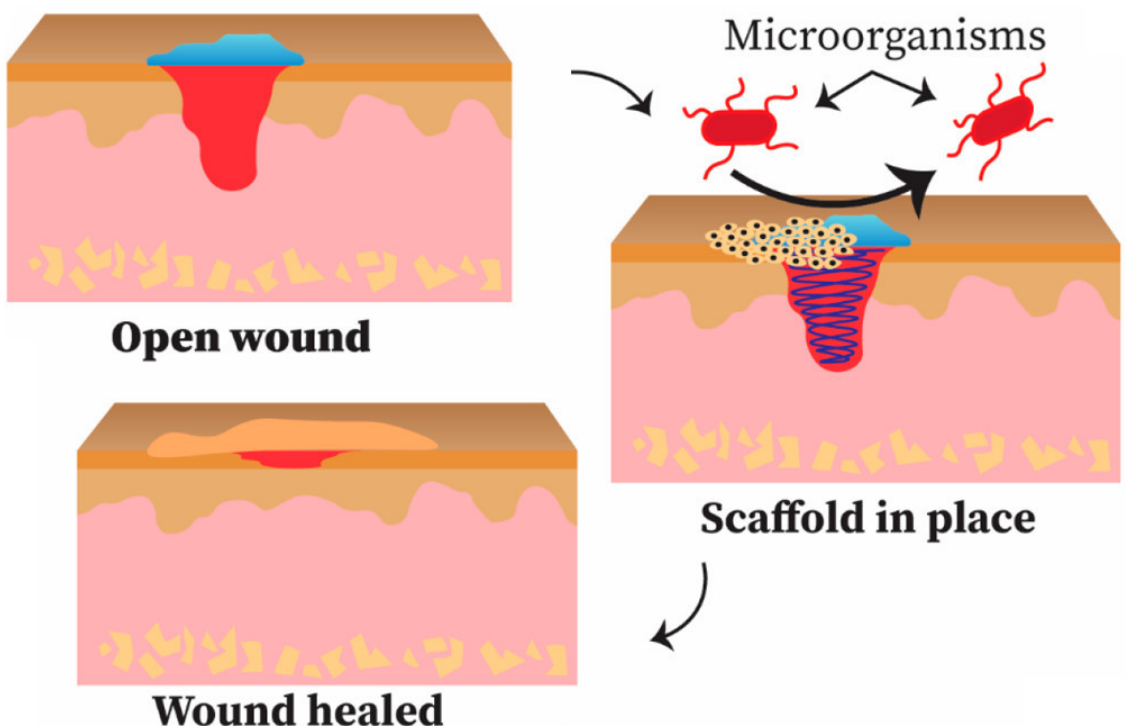
Figure 14. Schematic of how an electrospun scaffold containing GO/antimicrobial polymers may be effective in wound healing applications Reproduced with permission from Ref. [210]. Copyright 2021 the American Chemical Society.